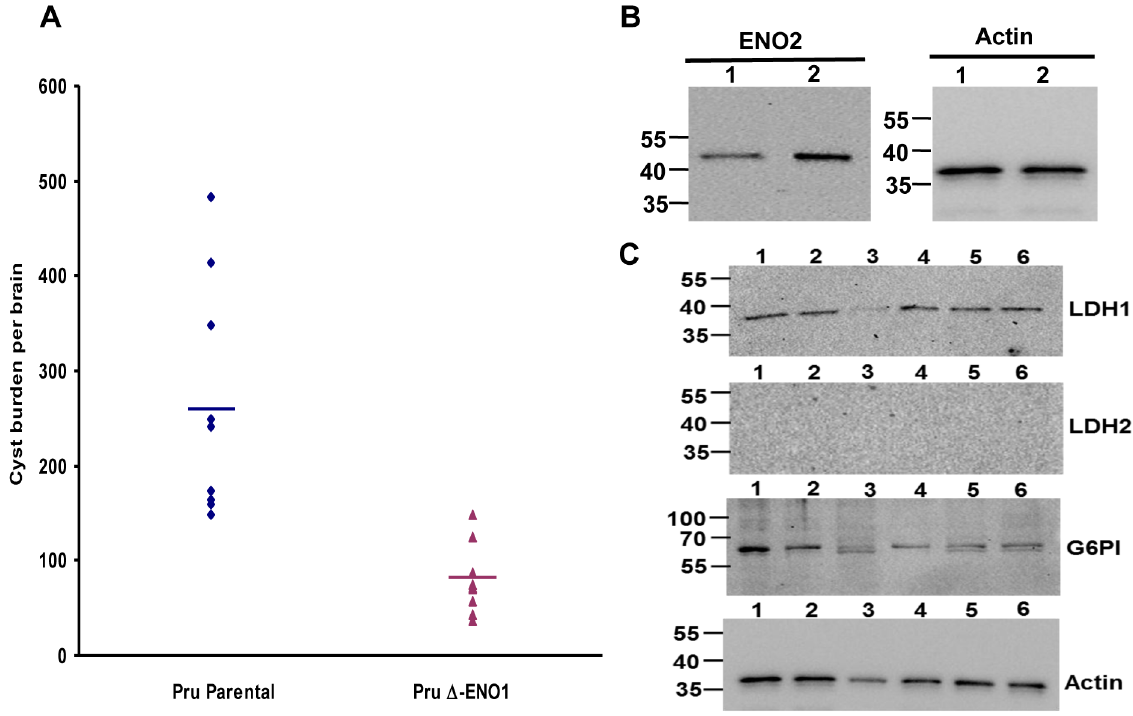
Figure 6. Targeted deletion of TgENO1 reduces cyst burden in the brain of chronically infected mice. A) The total number of cysts per brain of mice infected with 5 6 10 2 tachyzoites from the Pru D ku80 D Tgeno1 mutant or parental Pru D ku80 was counted after staining with FITC-labeled dolichol biflorus lectin. A group of nine mice was used for each experiment, and the experiment was repeated twice with similar results (n=2, P , 0.001). Cyst burden (total number of cysts per brain) of the Pru D ku80 D Tgeno1 mutant was significantly lower than that of the parental Pru D ku80 strain. B) Western blots of total SDS-extracted proteins from knockout Pru D ku80 D Tgeno1 mutants (lane 1) and parental Pru D ku80 tachyzoites (lane 2). Left panel was probed with the polyclonal anti-ENO2 antibodies while the right panel was stained with the monoclonal anti-actin antibodies. C) Western blots of mutants and wild type parasites. Lane 1, total SDS-protein extracts from wild type 76K tachyzoites. Lane 2, total SDS-extracted proteins from transgenic E1-5 tachyzoites. Lane 3, total SDS-extracted proteins from transgenic E2-4. Lane 4, total SDS-extracted proteins from transgenic E2-10. Lane 5, total SDS-extracted proteins from parental Pru D ku80 tachyzoites. Lane 6, total SDS-extracted proteins from knock-out Pru D ku80 D Tgeno1 mutants. Blots were stained with polyclonal antibodies specific to LDH1, LDH2, G6PI and monoclonal antibodies specific to actin. The numbers on the left indicate molecular markers in kilodaltons.